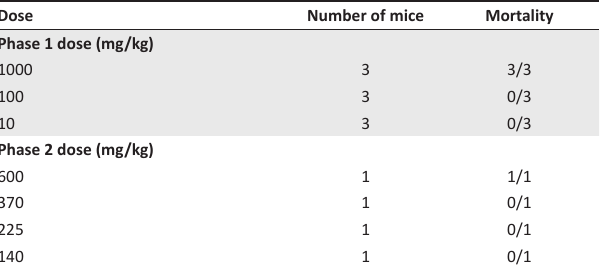
TABLE 2: Acute toxicity of ethyl acetate extract.